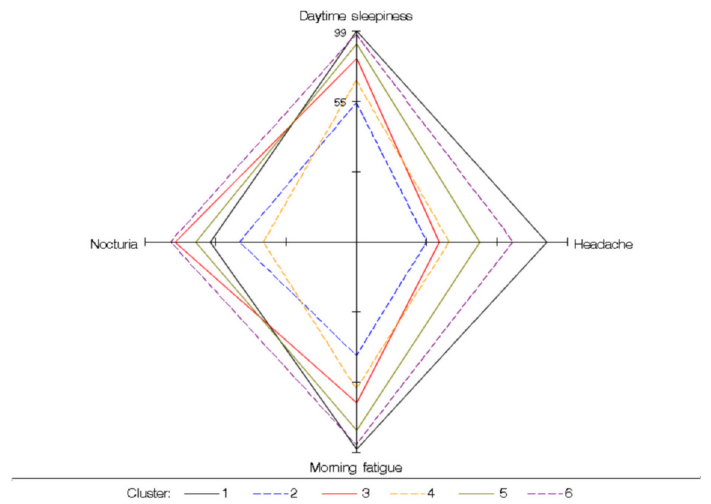
Fig 3. Conditional probabilities of symptoms to highlight the major differences among clusters. Cluster 1: the young symptomatic. Cluster 2: the old obese. Cluster 3: the multi-disease (MD) old obese. Cluster 4: the young snorers. Cluster 5: the drowsy obese. Cluster 6: the MD obese